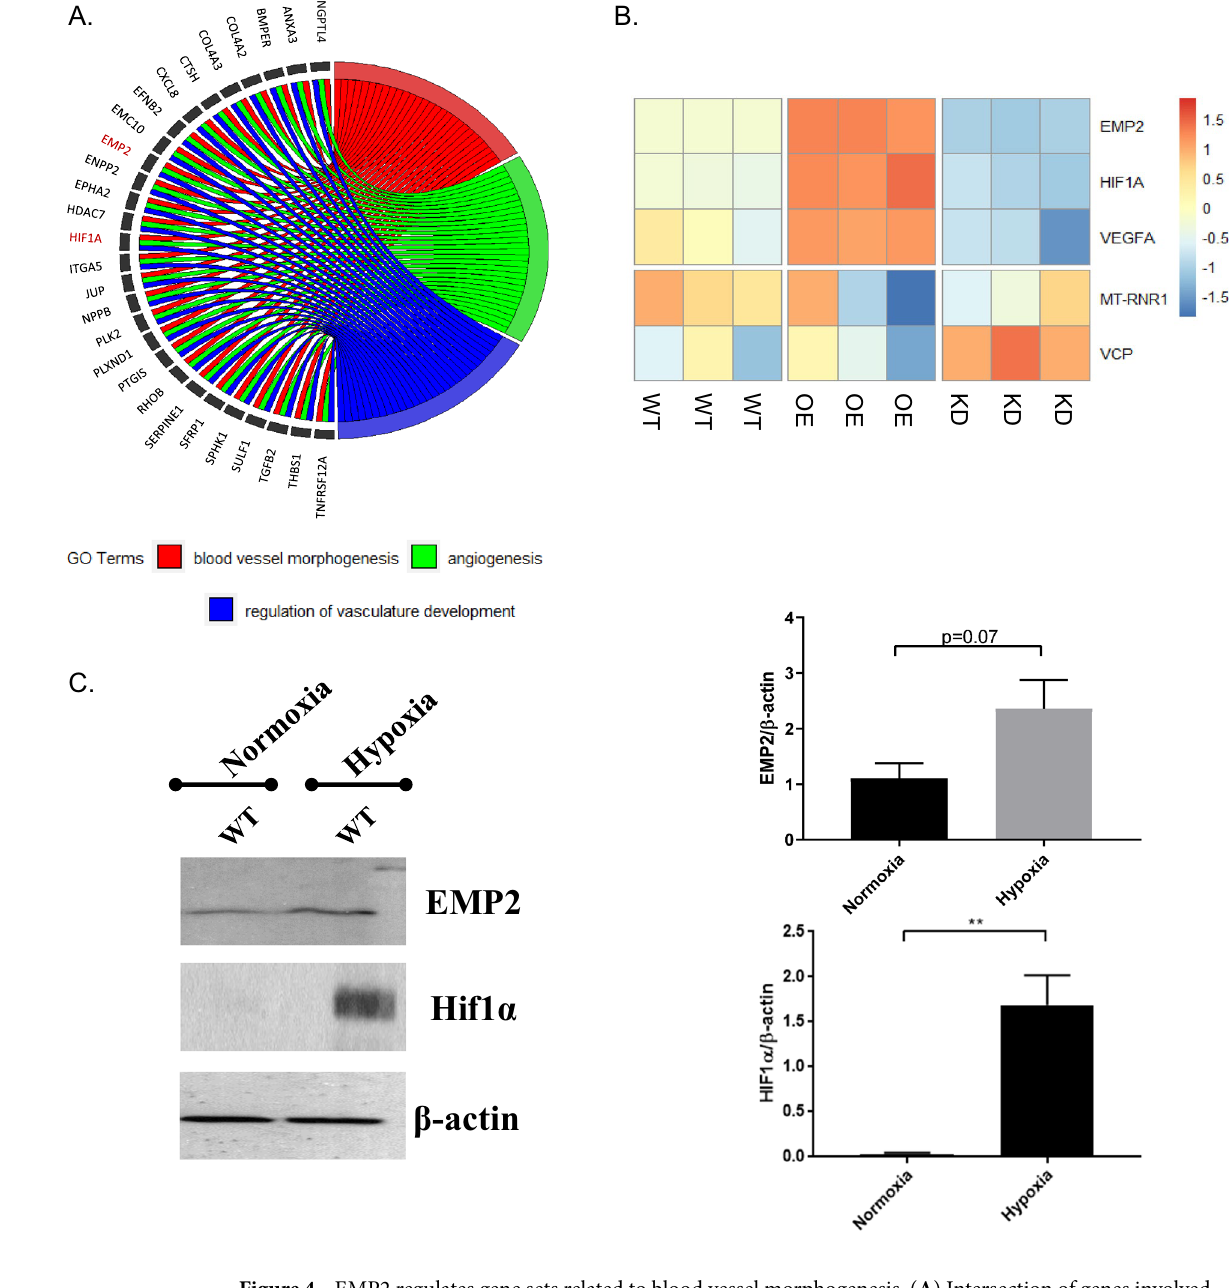
Figure 4. EMP2 regulates gene sets related to blood vessel morphogenesis. ( A ) Intersection of genes involved in neoangiogenesis and its related pathways depicted using a chord diagram. The chord diagram was generated in "GOplot", version 1.0.2 (https:// CRAN.R- proje ct. org/ packa ge= GOplot). ( B ) Heatmap of EMP2, HIF1α, and VEGFA expression in ARPE-19 cells with modified EMP2 levels. Successful EMP2 transcript alteration was confirmed for wild type (WT), EMP2 overexpressing (OE), and EMP2 knock down (KD) ARPE-19 cells. HIF1α and VEGFA expression correlates with EMP2 expression, with increased transcript levels in OE and decreased transcript levels in KD. The housekeeping genes MT-RNR1 (16S rRNA) and VCP were used as controls for normalization. All samples were performed in triplicate. ( C ) HIF1α expression is induced in ARPE-19 WT under hypoxic conditions. Analysis of HIF1α and EMP2 protein expression in WT ARPE-19 cells under normoxic conditions and following 2–4 h of hypoxic stress (0.5% O 2 ). Bands were visualized using autoradiography. Bar diagrams depict mean values and standard error of the mean. Statistical significance was established using a Student’s t -test (unpaired, two-tailed). **, p = 0.0076. Original, uncropped blots are presented in Supplementary Fig.